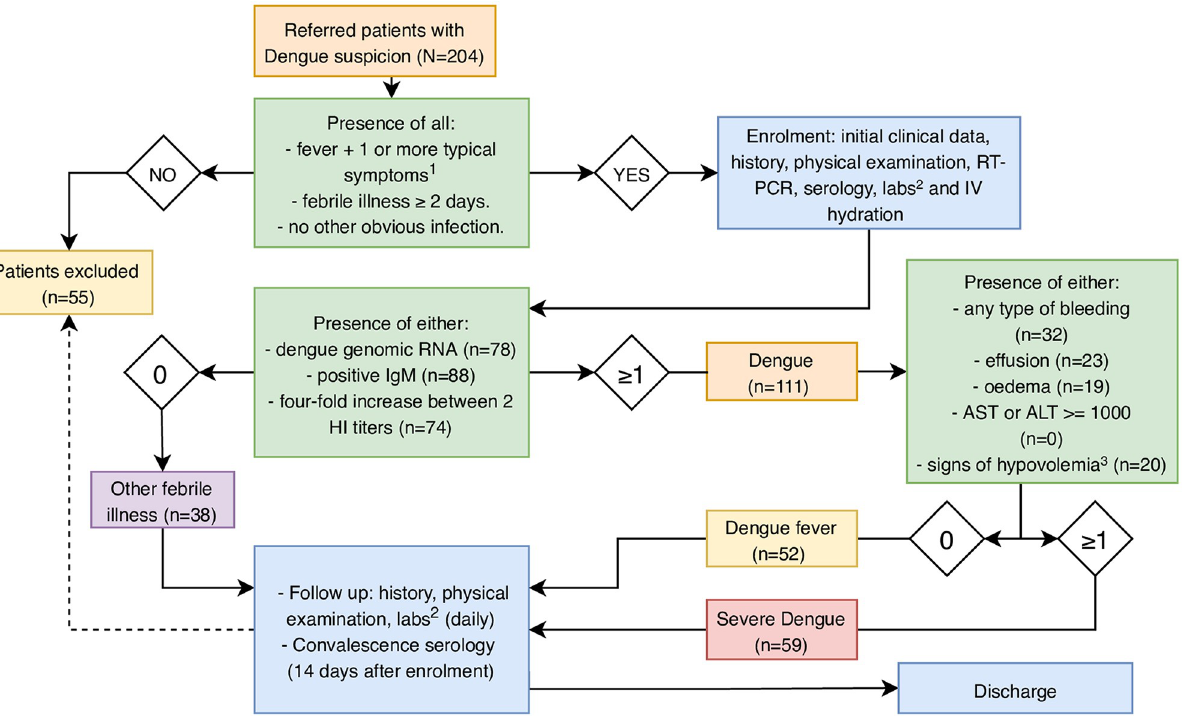
Fig 1. A. Diagram of the time-line for data collection. B. Flow diagram representation of study inclusion and exclusion criteria. Exclusion criteria included recumbent systolic blood pressure < 85 mmHg, significant bleeding prior to study enrollment, and patients unlikely to attend or that did not attend follow-up visits. 149 patients completed the protocol. 1 Headache, myalgia or maculopapular rash; 2 Routine laboratory testing: complete blood counts, PT, PTT, TT, albumin, AST and ALT. Specialized coagulation studies: TAT, F1+2, fibrinogen, D-D and vWF; 3 Signs of hypovolemia were defined using the following criteria: (heart rate / systolic blood pressure) � 1 or (systolic–diastolic blood pressure) � 20 mmHg; HI: hemagglutination inhibition; RT-PCR: reverse transcription polymerase chain reaction.